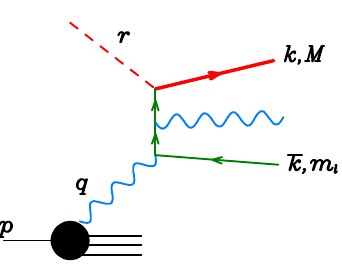
Figure 13. A diagram contributing at order (cid:11) 3 with up to three powers of log( M 2 = (cid:3) 2 ) to the probe